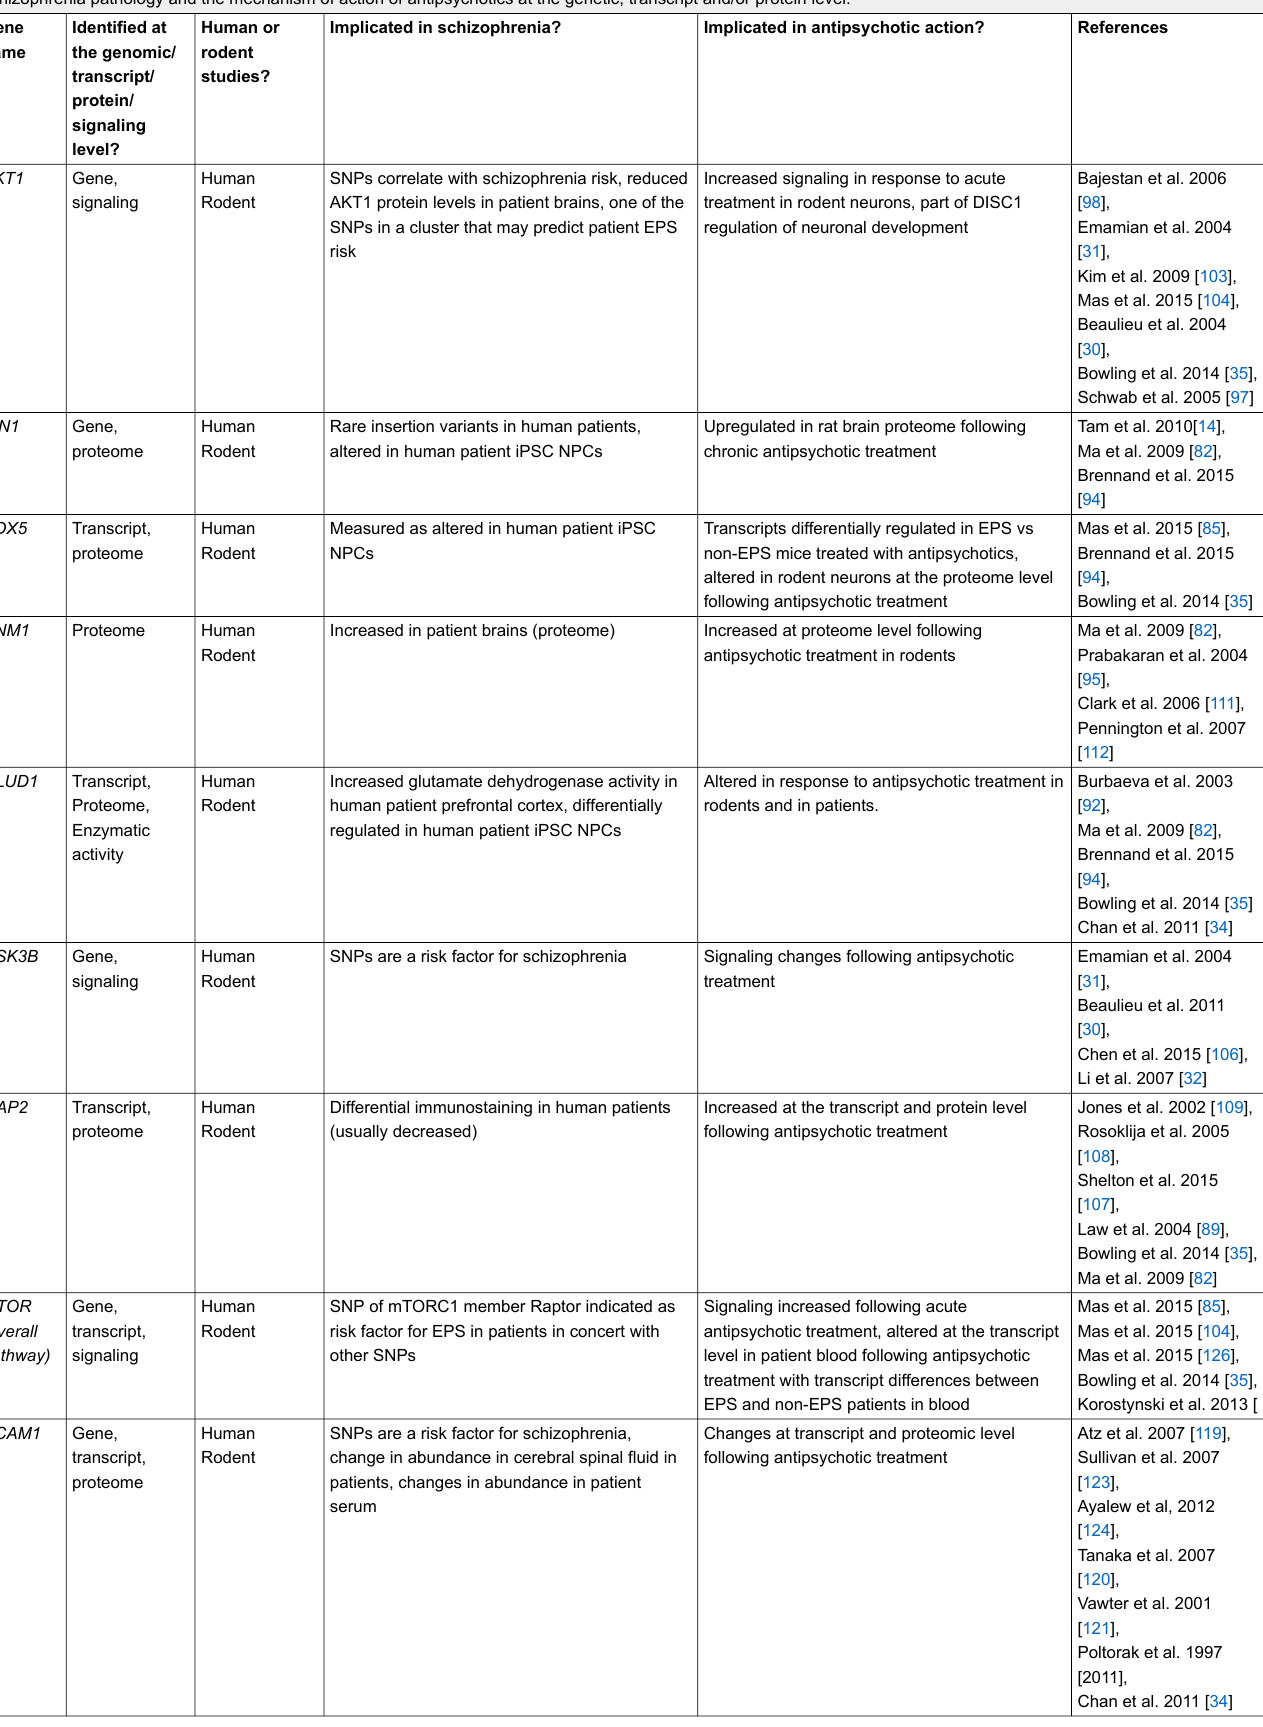
Table 2: Targets associated with both schizophrenia pathology and antipsychotic action. The following genes have been implicated in at least three studies in both schizophrenia pathology and the mechanism of action of antipsychotics at the genetic, transcript and/or protein level. Gene